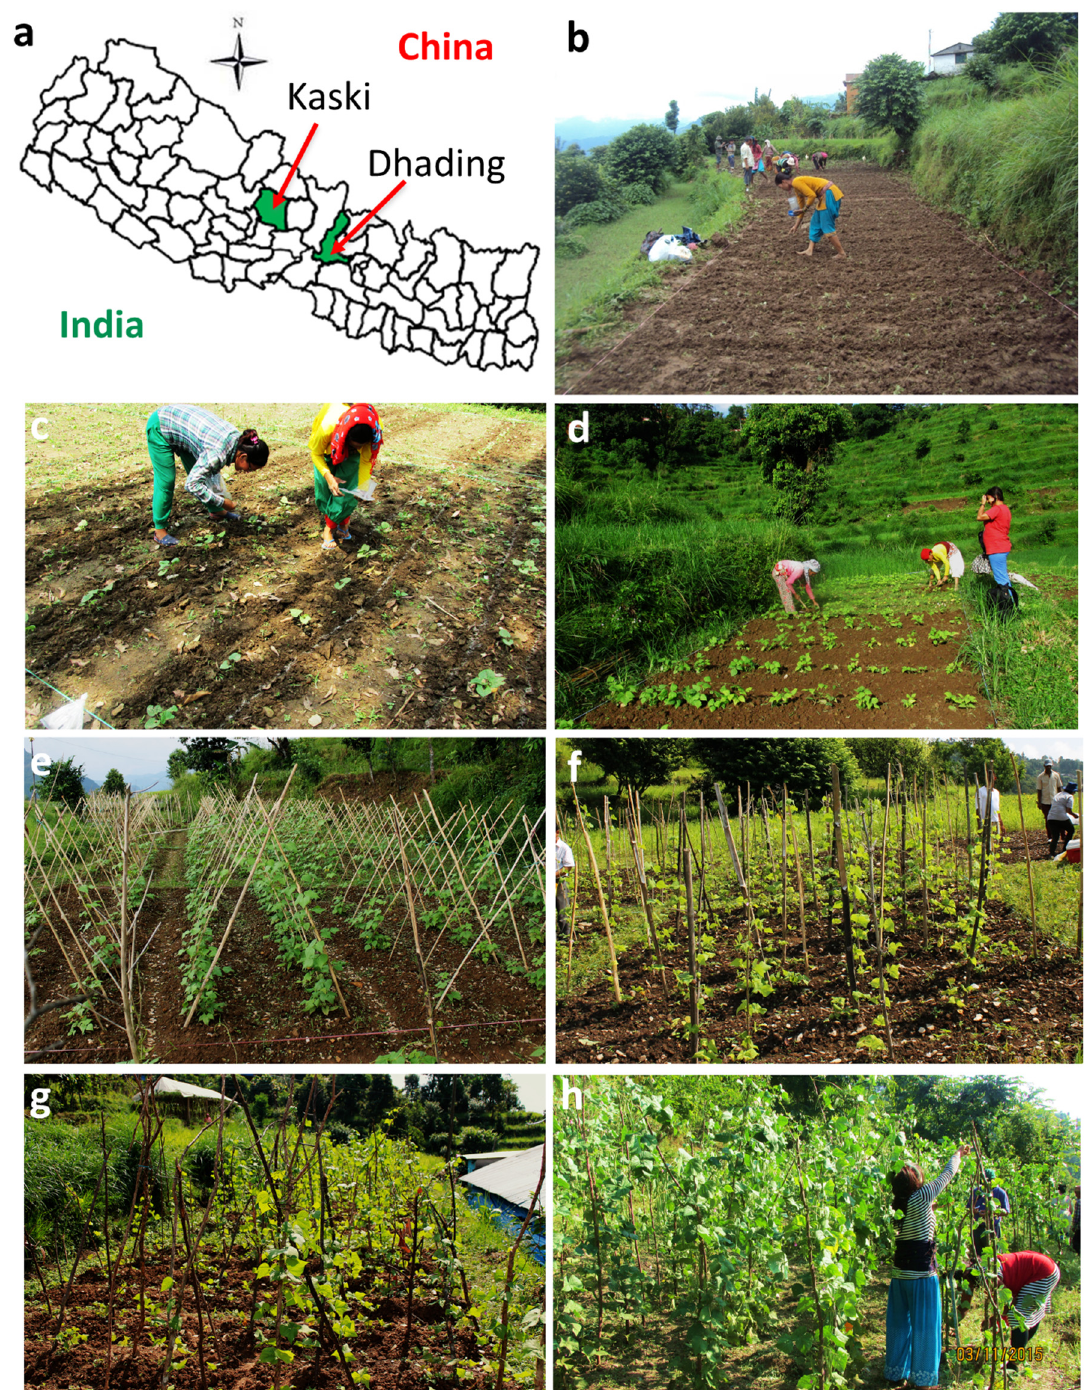
Figure 1. Participatory on-farm trials in the mid-hills region of Nepal (Kaski and Dhading districts). ( a ) Map of Nepal showing the geographical location of the trial sites (green color). ( b ) Seeding of common bean plots in terrace farm fields by Local Initiatives for Biodiversity, Research and Development (LI-BIRD) staff. ( c ) Application of micronutrients (Mo and B) after one week of germination by LI-BIRD staff. ( d ) Traditional manual weeding practices carried out by farmers under the supervision of LI-BIRD staff. ( e – g ) Different trellis practices used by individual farmers in Kaski during 2015. ( h ) Common bean plots at the pod filling stage.